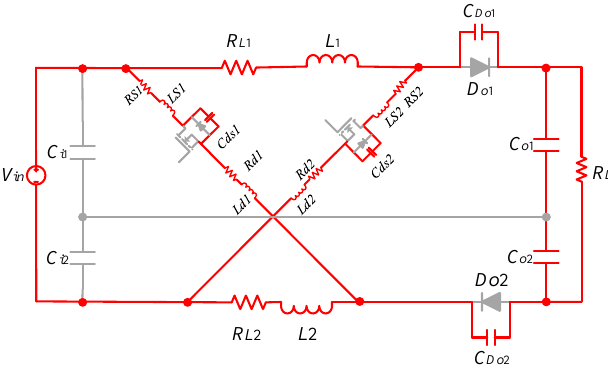
Figure 8. Equivalent circuit of Sneak Mode 2.